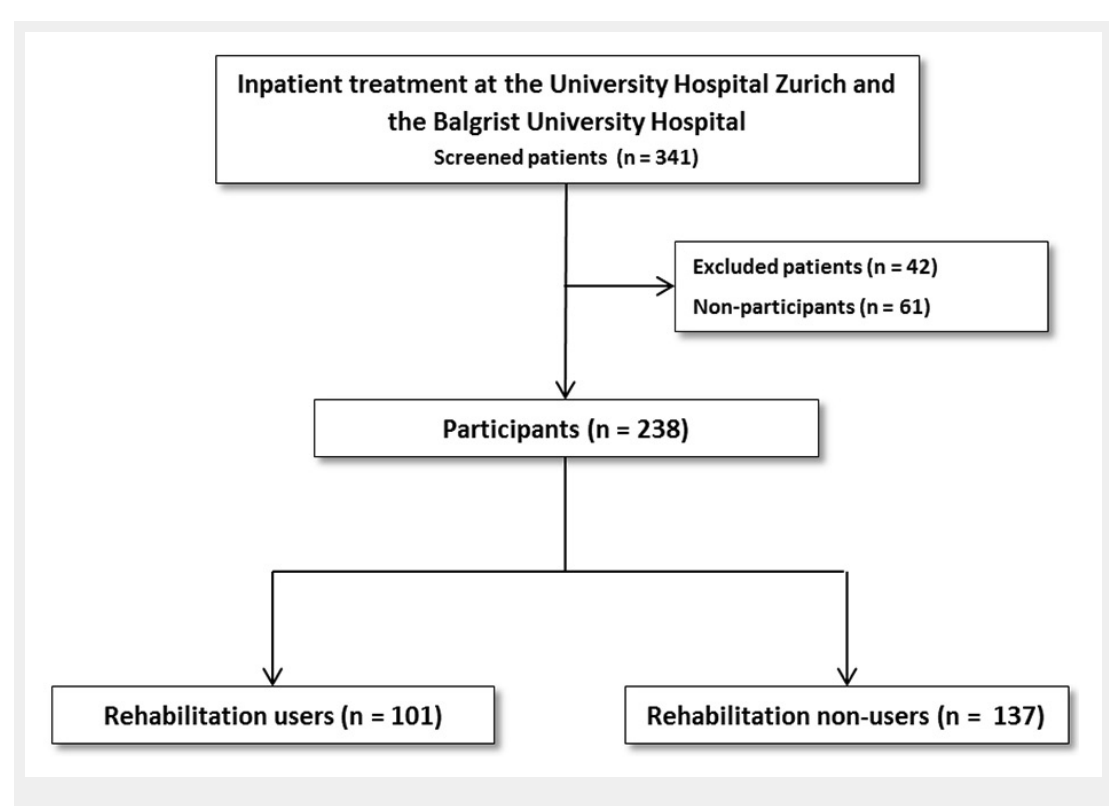
Figure 1 Flowchart of study participants vs nonparticipants, rehabilitation users vs rehabilitation